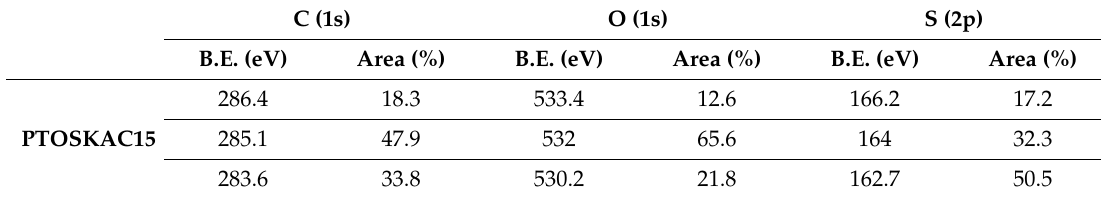
Figure 8. C(1s), O(1s) and S(2p) XPS spectra of PTOSKAC15. Table 4. Subdivision of carbon, oxygen and sulfur signals for